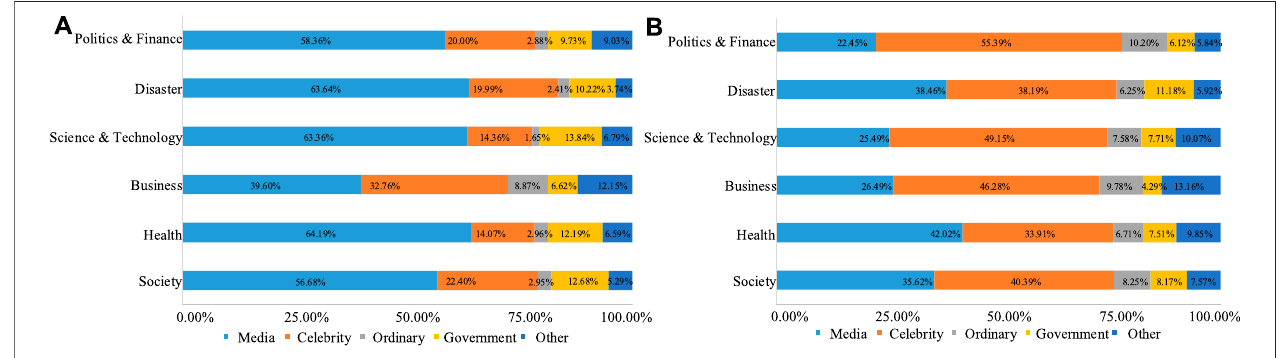
FIGURE 4 | Proportion of account types in (A) debunked posts (DPs) and (B) non-debunked posts (NDPs) under six types of fake news. Notes: Other types of accounts include Weibo got talent, enterprise, campus, organization, website, and Weibo girl accounts.